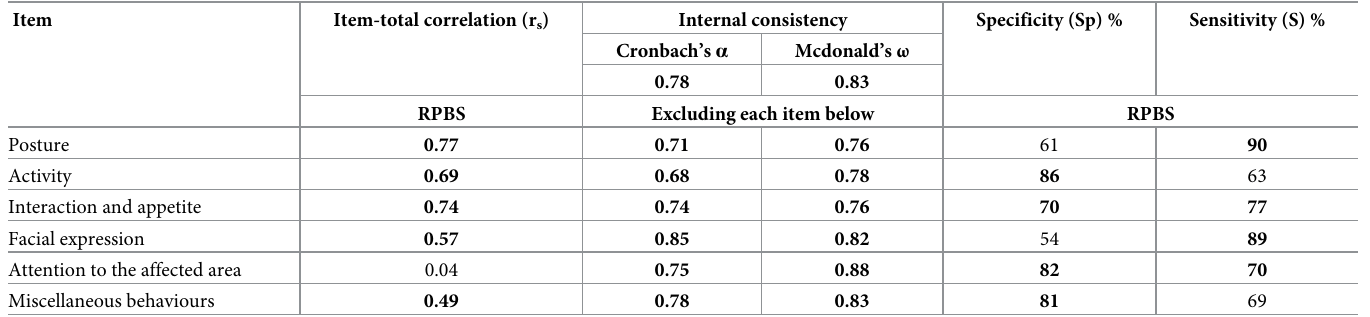
Table 10. Item-total correlation, internal consistency, specificity, and sensitivity of the RPBS.